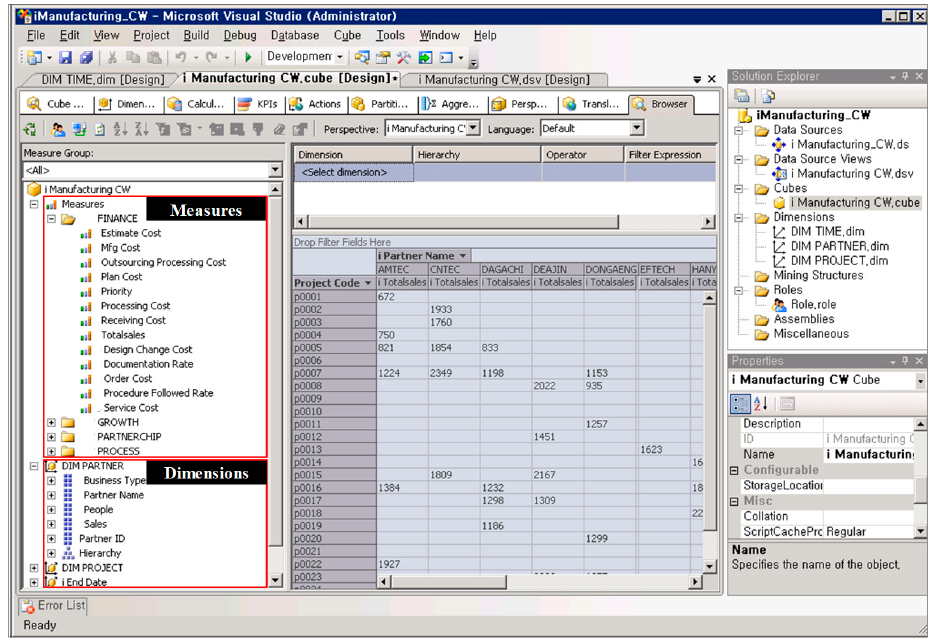
Figure 4. Implementation of a process warehouse and a process cube for supporting operational data analysis in supply chain management.